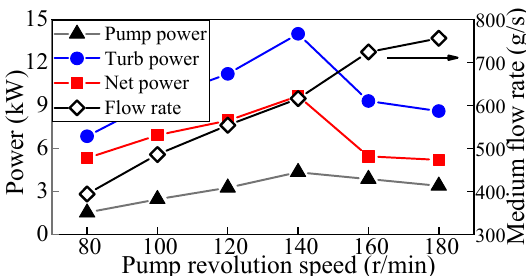
Figure 5. Changes of net power of the system with pump speed.